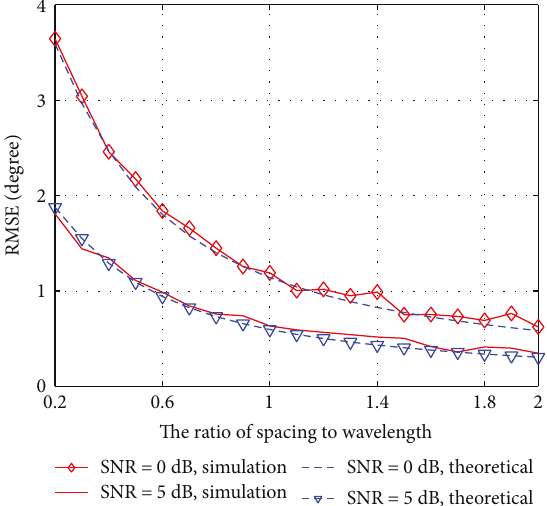
Figure 1: The root-mean-square error (RMSE) of the DOA estimation versus the number of antenna element with the signal coming from 30 ° and the spacing between adjacent elements being equal to half wavelength.